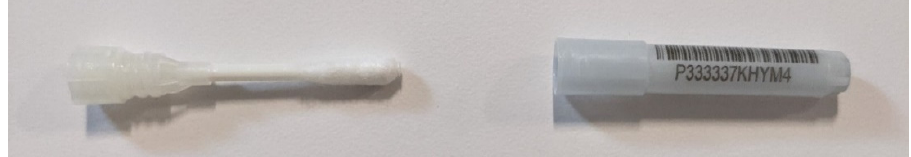
Figure 1. XpressCollect swab ( left ) and tube ( right ).